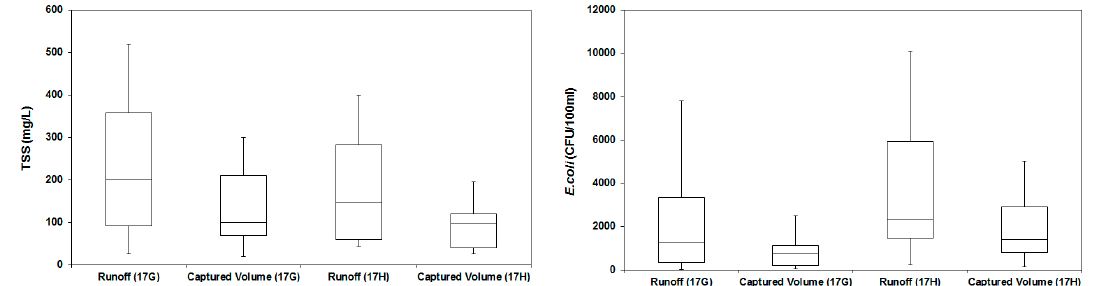
Figure 4. The total suspended solids (TSS) and Escherichia coli ( E. coli ) concentrations for runoff and captured volume samples between the trench (17G) and shaft (17H) systems. Each box illustrates the 25th percentile, the median, and the 75th percentile. The highest and lowest values are represented by the top and bottom whiskers.